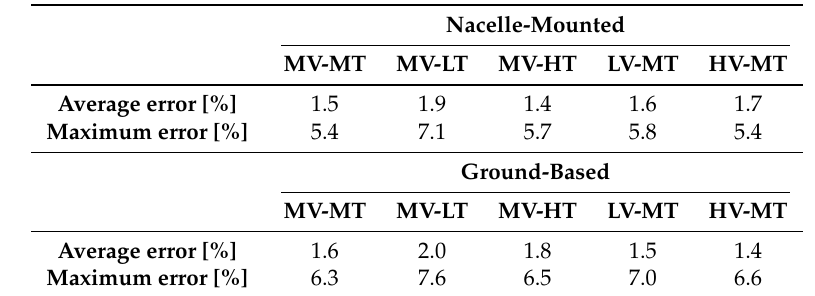
Table 5. Total average and maximum errors for the reconstruction of u ( x , y , z ) inside the volume of interest for all inflow cases studied and both lidar locations with the overall optimum angular resolution of 3 ◦ . The errors are shown as a percentage of the undisturbed wind speed at hub height (see Section 2.1.3). The optimum values found in Table 4 correspond to the first column of this table.